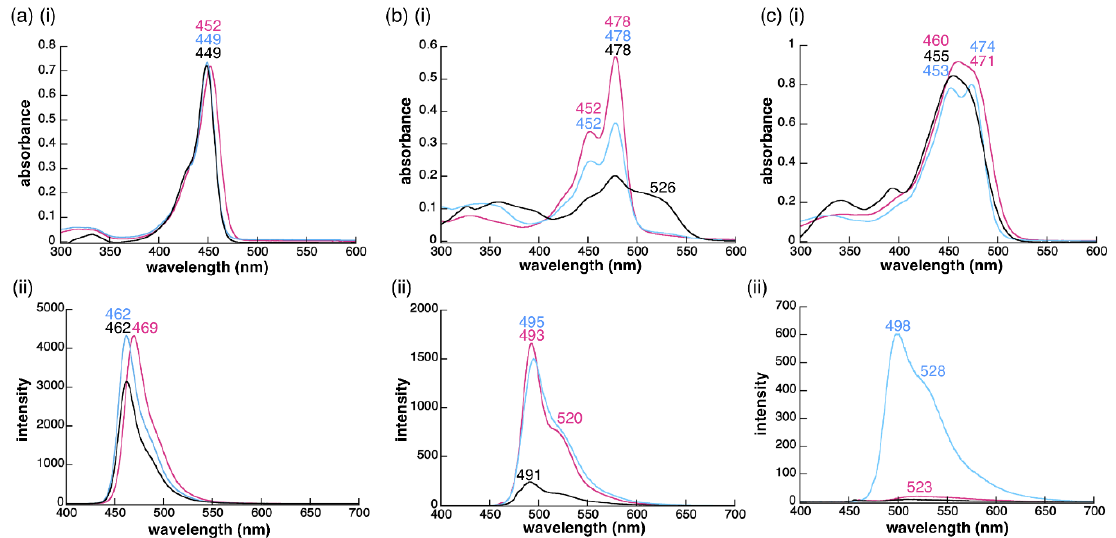
Figure 2. ( i ) UV/vis absorption and ( ii ) fluorescence spectra, with excitation at absorption maxima, of ( a ) 1b (0.01 mM), ( b ) 2a (0.01 mM), and ( c ) 2b (0.02 mM) in toluene (cyan), CH 2 Cl 2 (red), and THF (black).